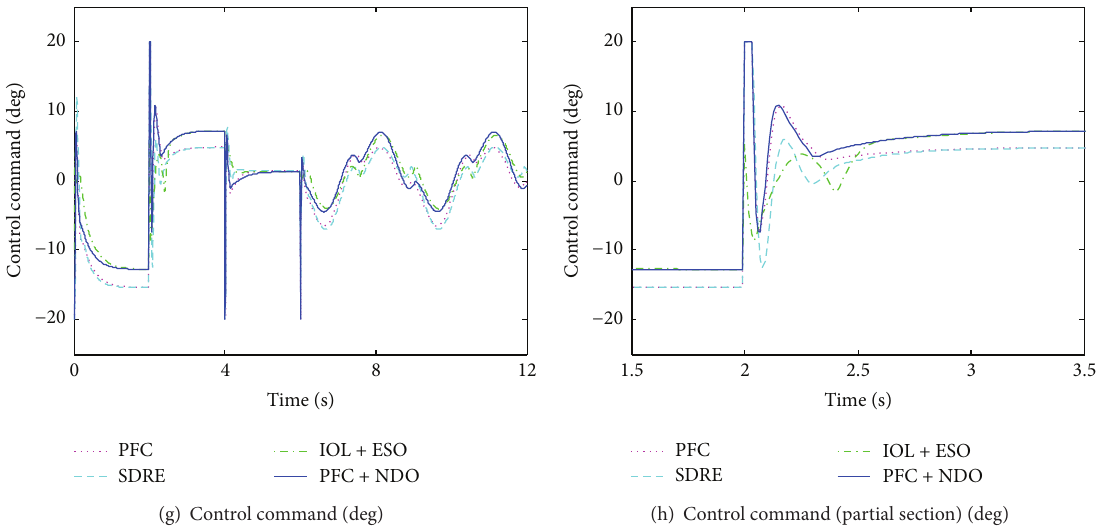
Figure 2: Simulation responses under the four controllers and the estimate performance of the NDO in the case of positive uncertainties and